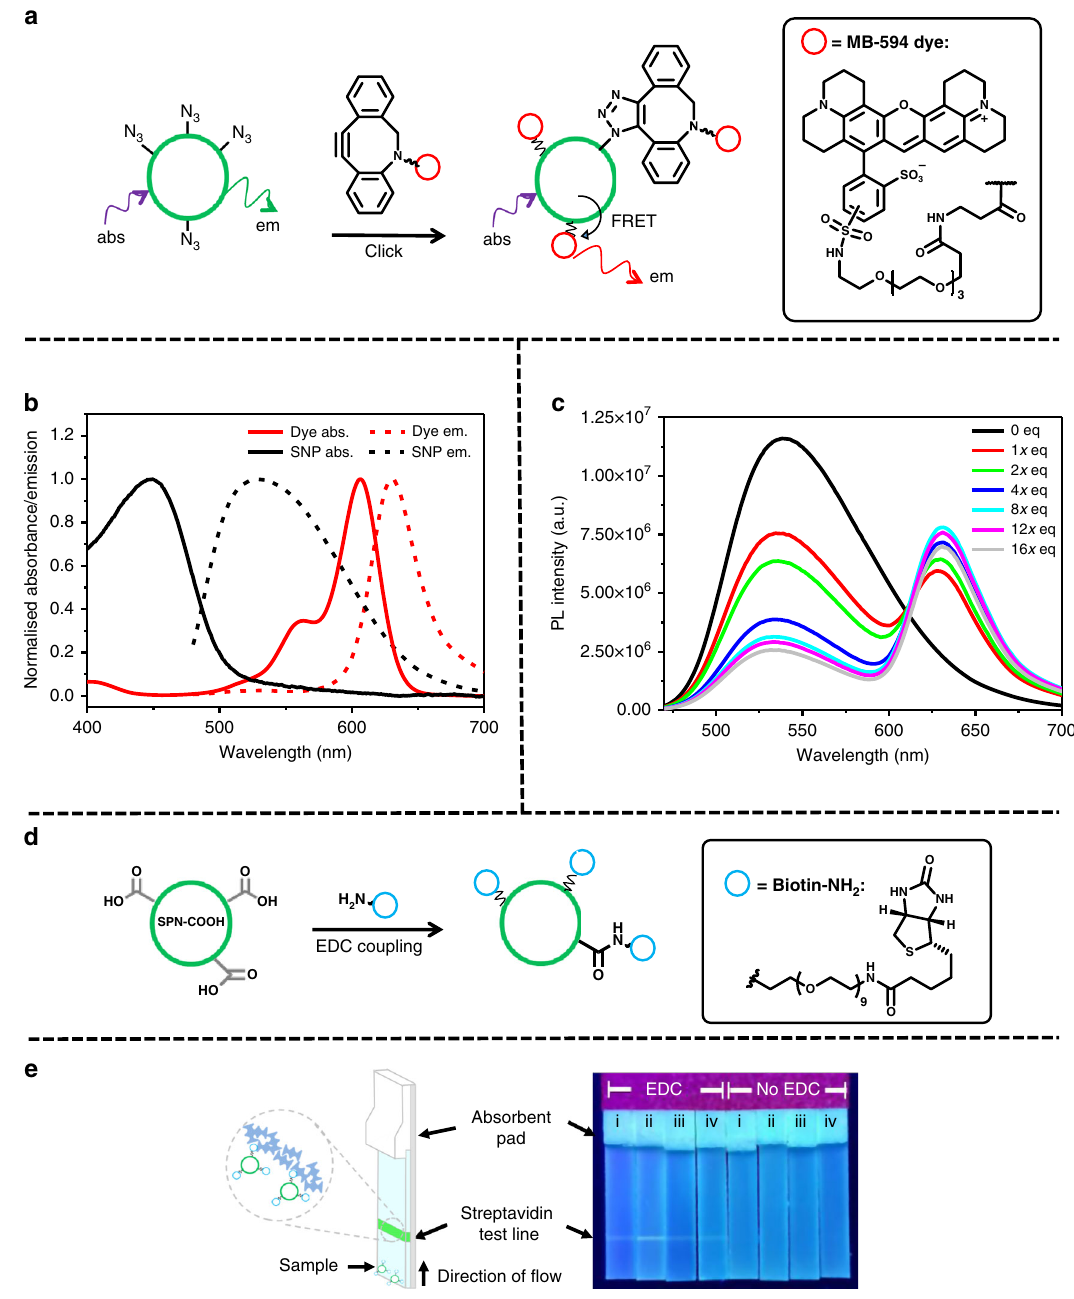
Fig. 5 SPN surface monofunctionalisation. a Schematic of the modi fi cation of the surface of SPN-N 3 with active dye, enabling FRET between dye and nanoparticle. b Normalised absorbance (solid lines) and emission (black lines) spectra of the dye (red lines) and the nanoparticles (black lines). c PL spectra of SPN-N 3 with increasing equivalents of active dye, x = 423 dye molecules per nanoparticle (concentration of nanoparticle calculated with NTA) excited at 450 nm, all at the same nanoparticle concentration. d Schematic of the EDC coupling on the surface of SPN – COOH with a biotin functionalised amine. e Illustration of the components of a poly-streptavidin test strip with image of the test line run with particles functionalised with and without EDC present at increasing concentrations of biotin-NH 2 : (i) 1 μ g mL − 1 , (ii) 10 μ g mL − 1, (iii) 100 μ g mL − 1 and (iv) 200 μ g mL − 1 in nanoprecipitation method as before and particles were found to react with biotin-NH 2 and DBCO-594 separately, in the same fashion as SPN-COOH and SPN-N 3 , respectively (Supplemen- tary Figures 38 and 39). Adding DBCO dye fi rst or at the same time as other reactants was found to inhibit EDC coupling, most likely due to surface bound dye blocking further reactions.